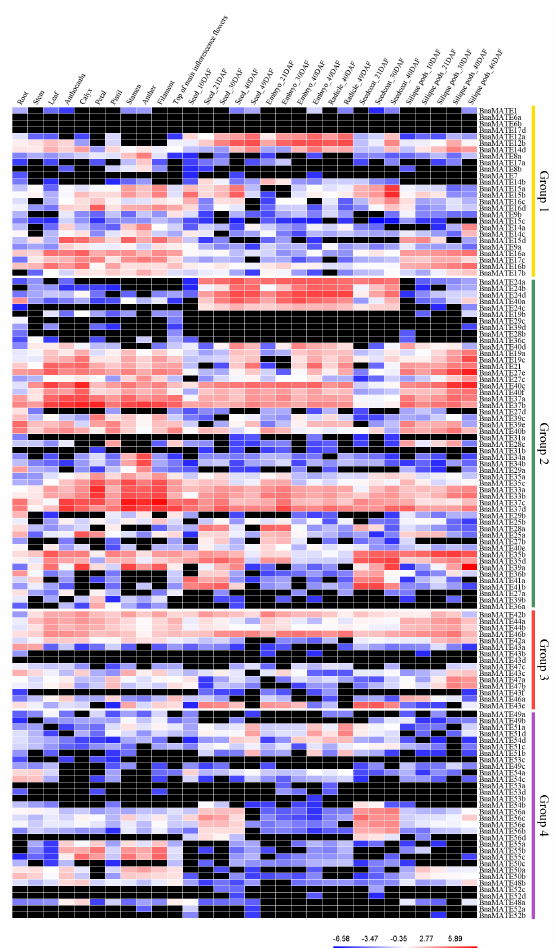
Figure 5. Expression patterns of all 124 BnaMATE genes in 15 di ff erent tissues at di ff erent developmental stages in B. napus . The color bar represents log 2 expression levels (fragments per kilobase per million mapped fragments, or FPKM). Red, blue, and white indicate high, low, and medium expression levels, respectively, and black indicates no expression (FPKM = 0). The abbreviations above the heatmap indicate the di ff erent tissues and organs / developmental stages of B. napus ZS11 (listed in Table